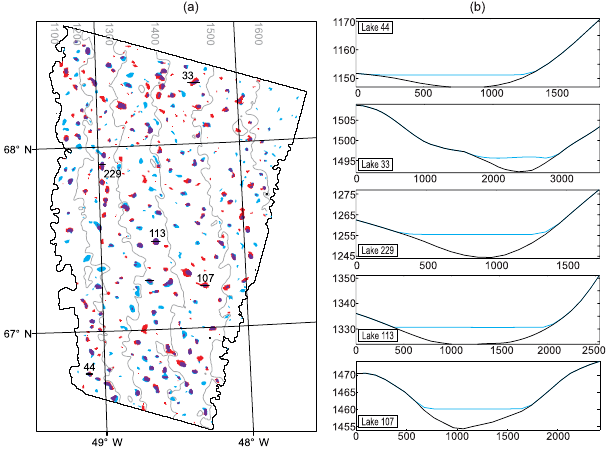
Fig. 3. (a) Composite plot of all MODIS-observed lakes (red) and all lakes simulated using the transient version of the model (blue) at a 90-s resolution for the 2003 melt season. Coincident lake area is shown in purple. (b) East–west lake surface (blue) and bed (black) profiles for modelled lakes indicated by number in the main plot. The transect taken is shown in black in (a)